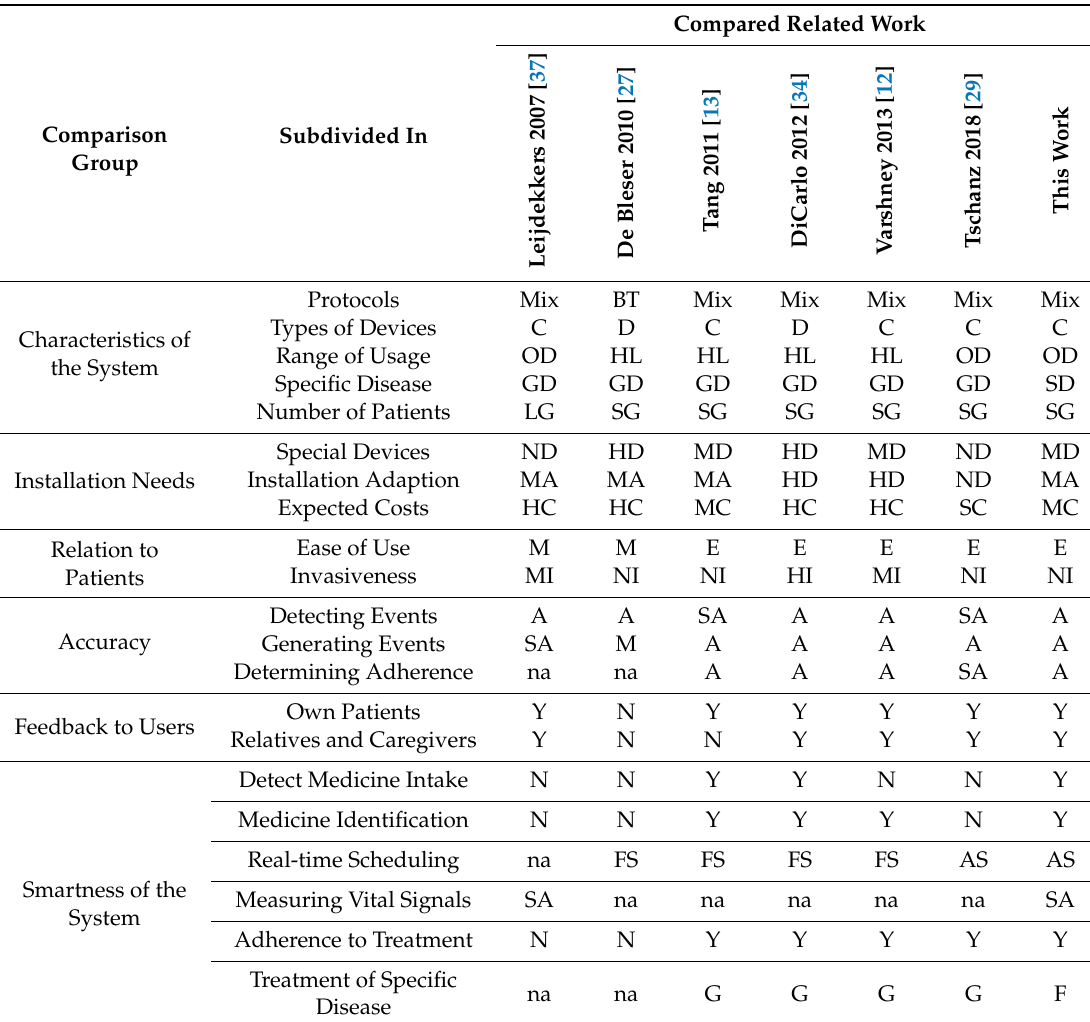
Table 6. Comparison of the presented work with similar